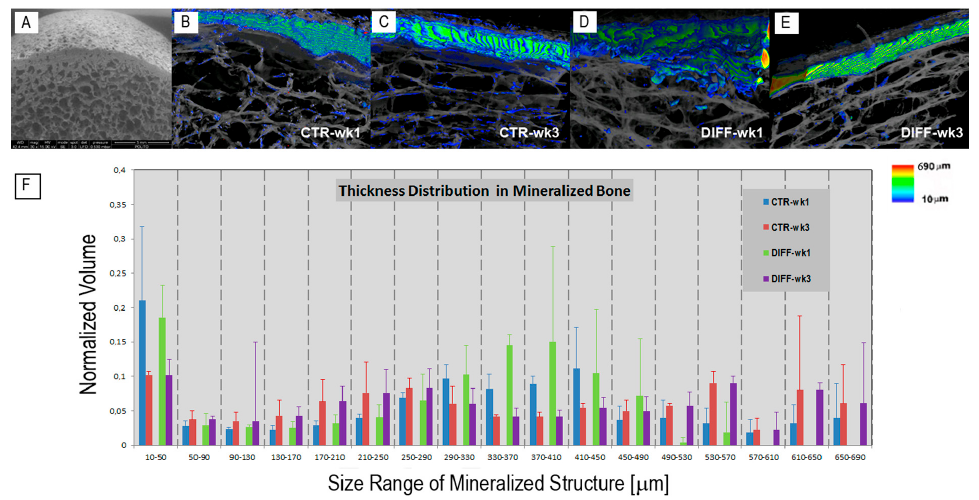
Figure 1. ( A ) Scanning electron microscopy image of the Osteobiol ® Dual Block before cell seeding: the cortical bone is anchored to cancellous bone, mimicking the natural human bone architecture; ( B – E ) Dual Block cultured with human Periodontal Ligament Stem Cells in xeno-free media. Synchrotron Radiation Phase-Contrast Microtomography (SR-PhC-microCT) three-dimensional (3D) images of sampling sub-volumes in ( B , C ) basal; and ( D , E ) osteogenic conditions. The cross-talk between cells, media, and scaffold produced 3D microCT images with two different phases, corresponding to different δ (refractive index decrement) values: the phase corresponding to demineralized Dual Block (DB) scaffolds (rendered in translucent gray) and the phase due to the contrast produced by the newly formed mineralized bone (colored in agreement to the color map of bone thickness distribution on the right); ( B , D ) at week 1; ( C , E ) at week 3; ( F ) Histograms of the fully mineralized bone thickness distribution in the trabecular portion of the investigated samples at weeks 1 and 3 of